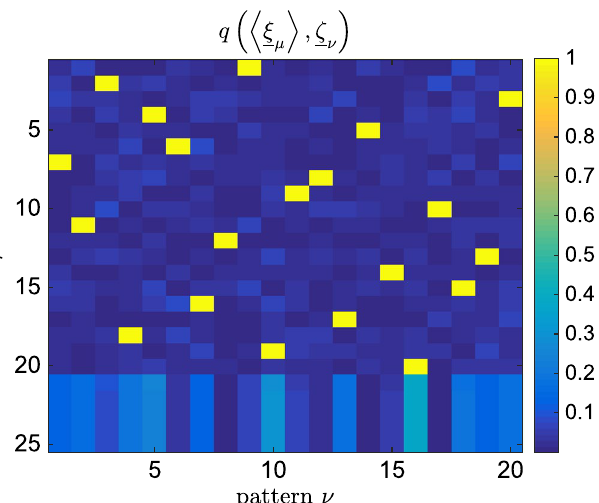
Figure 1. Overlap between the teacher’s pattern and pattern recovered by the student when using Eq. (4) with 1 , as a function of the number of samples M , at different temperatures. System size is N P = β < 1 , there exists a critical value of M O ( N ) below which it is impossible to infer the pattern, whereas above ∼ only a finite set of samples is needed.